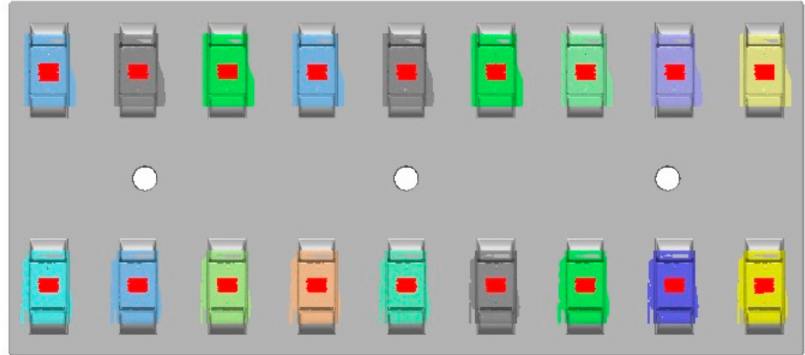
Figure 16. The 18 supporting block planes fitting